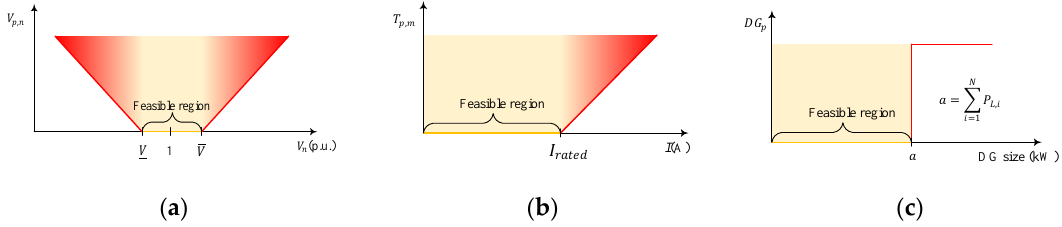
Figure 1. Penalty functions for ( a ) voltage magnitudes, ( b ) thermal limits, and ( c ) distributed generator (DG) sizes.